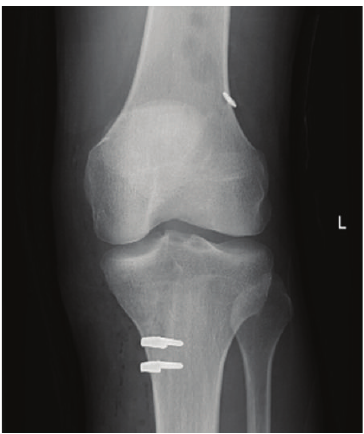
Figure 1: X-ray of the septic ACL reconstructed knee.